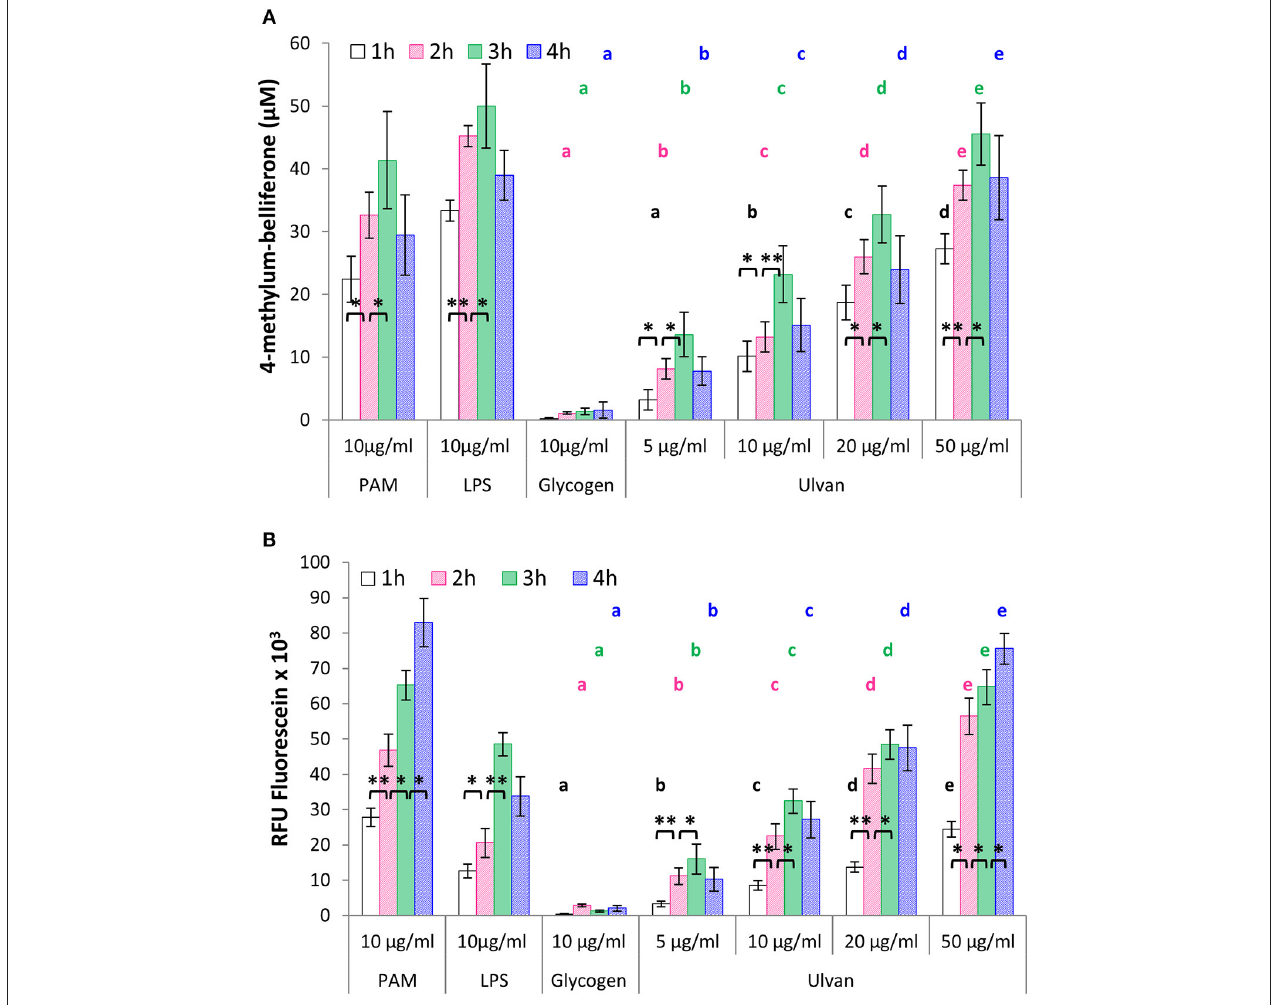
FIGURE 2 | Ulvan activates heterophils in vitro in a time- and dose-dependent manner. Heterophils (8 × 10 6 /ml) were incubated in vitro with different concentrations of ulvan, PAM as TLR2 agonist, LPS as TLR4 agonist, and glycogen as a control of polysaccharide specificity. Activation was evidenced by the quantification of degranulation as evidenced by β -D-glucuronidase ability to generate 4-methylum-belliferone (A) ; and the measurement of the oxidative burst as evidenced by fluorescein fluorescence (B) . Data represents the mean ± SEM of five independent experiments in triplicate. * p < 0.05, ** p < 0.01 for statistically different values for the same dose at different times. Different letters with the same color indicate statistically different values for the different doses at the same time ( p <